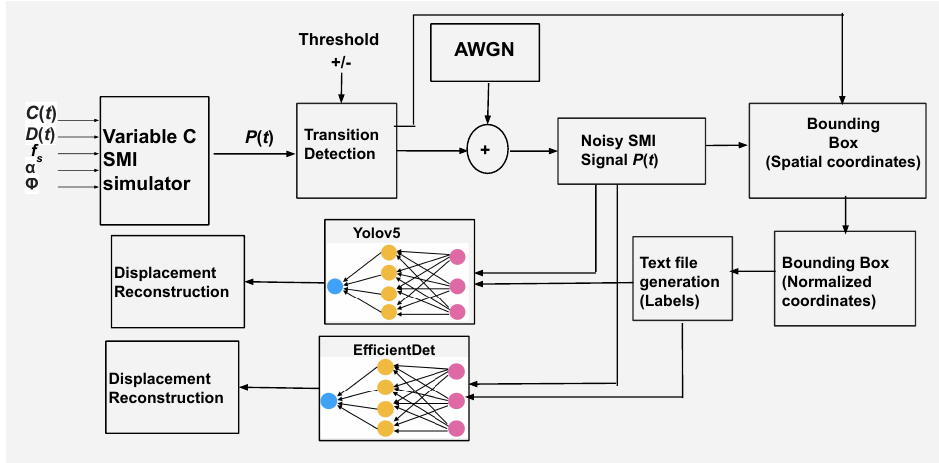
Figure 3. Schematic block diagram of complete system including generation of VOF-based SMI signals, proposed fringe labelling method, training of neural networks and displacement reconstruction. After training, unseen experimental signals were used for testing. AWGN denotes additive white Gaussian